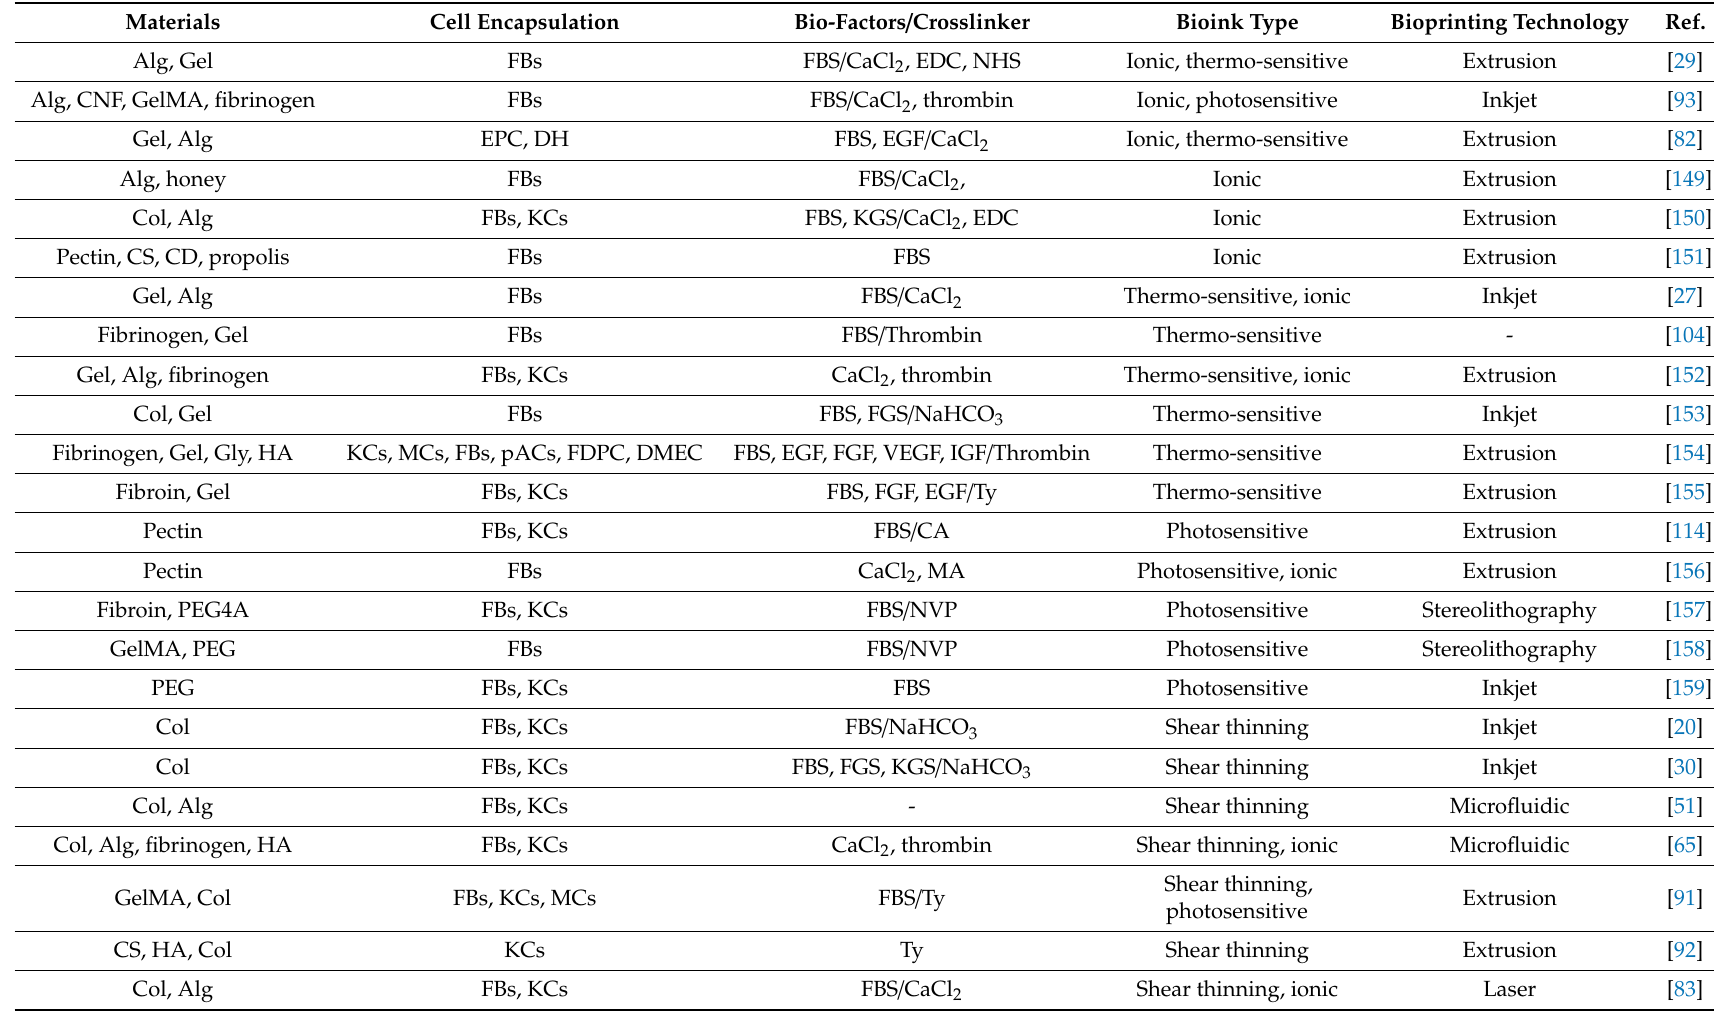
Table 4. Materials, cell encapsulation, bio-factors, crosslinker, bioink types, bioprinting technology of the bioink products for skin printing